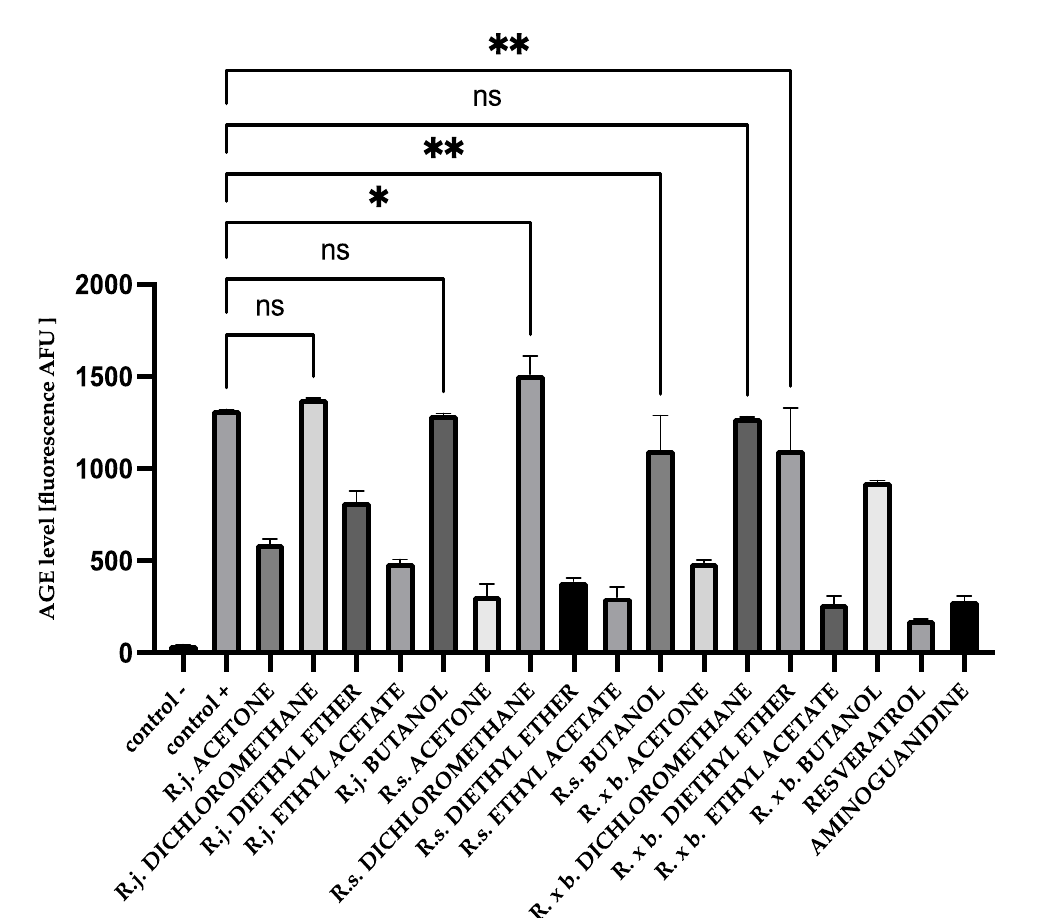
Figure 5. The effect of extracts and fractions on the formation of fluorescent AGEs in the in vitro HSA glycation. R.j., R.s., and R. × b. means Reynoutria japonica , Reynoutria sachalinensis , and Reynoutria × bohemica , respectively. Error bars shown in this figure are means ± SD for n ≥ 5. ** Statistically significant at p ≤ 0.01 compared to control +; * statistically significant at p ≤ 0.05 compared to control +; ns—not statistically significant at p ≤ 0.05. All other results are statistically significant at p ≤ 0.0001 compared to control +. Detailed information can be found in the Supplementary Material.